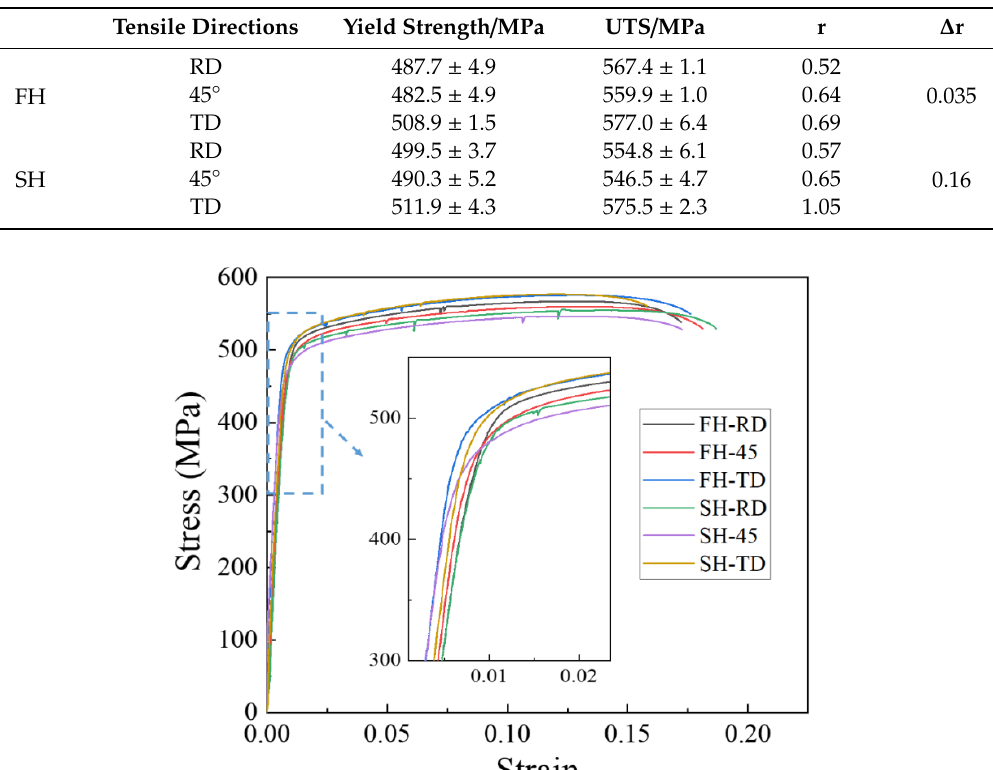
Table 4. Yield strength, tensile strength, and r-values along di ff erent tensile directions of the FH and SH samples after artificial aging (T6).